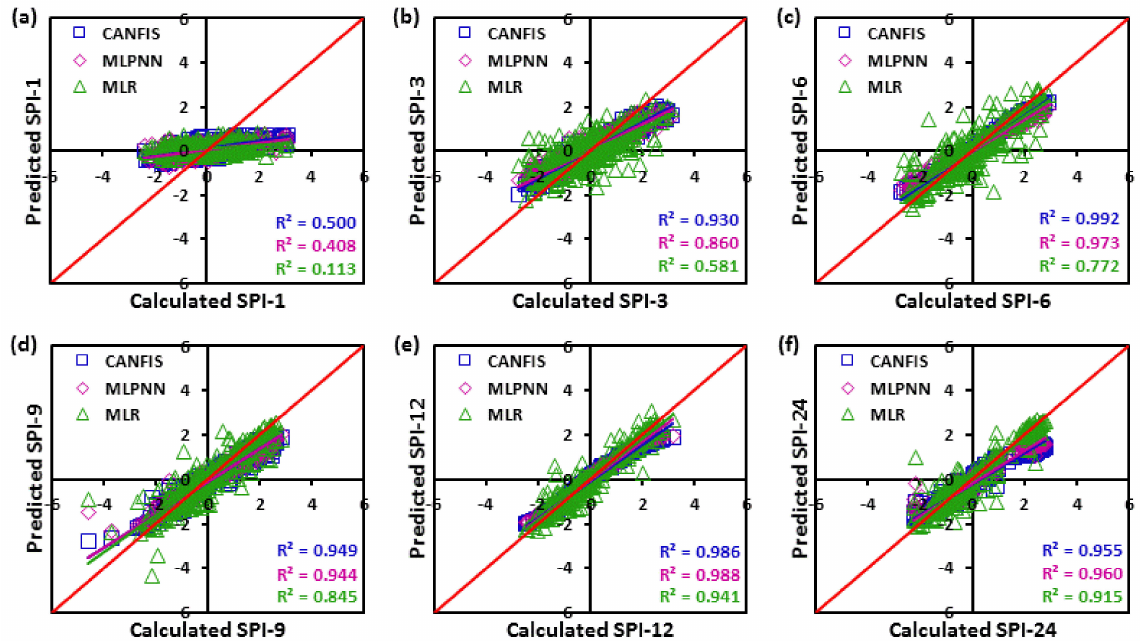
Figure 7. ( a – f ) Scatter plots of calculated and predicted multi-scalar SPI values by CANFIS, MLPNN, and MLR models during the testing period Pauri Garhwal